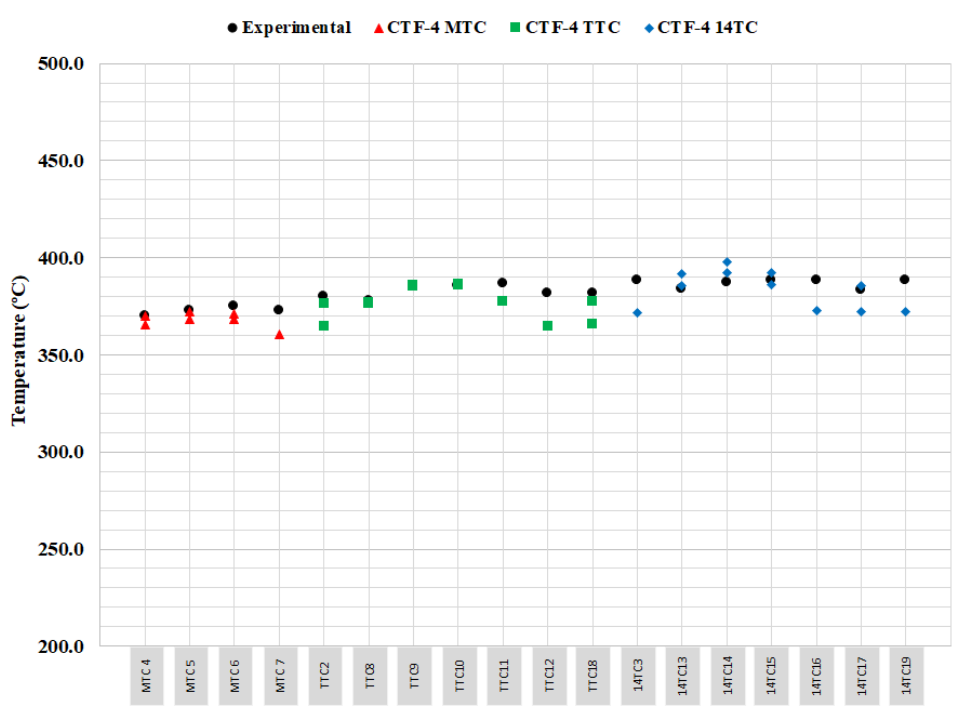
Figure 3. SHRT-17 steady state temperature predictions for XX10